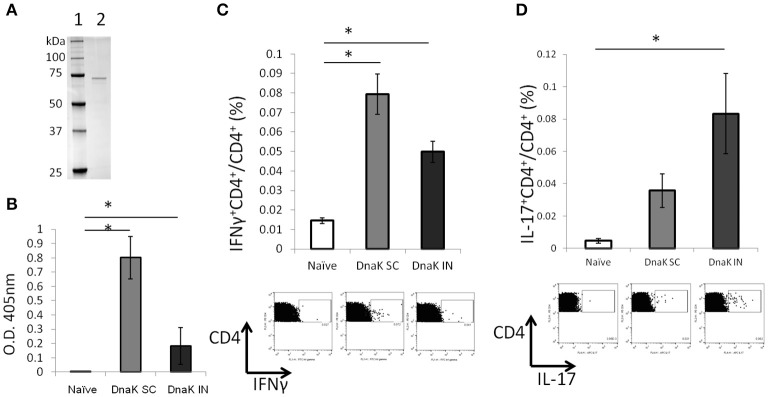
Vaccination with DnaK protein alone generates immunoglobulin responses and antigen-specific CD4+ T cells. (A) SDS/PAGE analysis of purified DnaK protein. Lane 1: protein ladder, Lane 2: Purified His-tag Dnak protein. C57BL/6J mice were vaccinated twice with DnaK (100 μg) by subcutaneous (SC) injection or with DnaK (20 μg) by intranasal (IN) injection. Immunological reponses were measured 2 weeks after the last vaccination. (B) Serum IgG responses to DnaK were measured by ELISA. Mean ± SEM, N = 3–4, *p < 0.05 compared to the other two groups. (C,D) Splenocytes were stimulated with DnaK protein (10 μg/ml) and intracellular cytokine staining was used to detect antigen-specific CD4+ T cells secreting IFNγ (B) and IL-17 (C). Mean ± SEM, N = 3–4, *p < 0.05 compared to the other group.